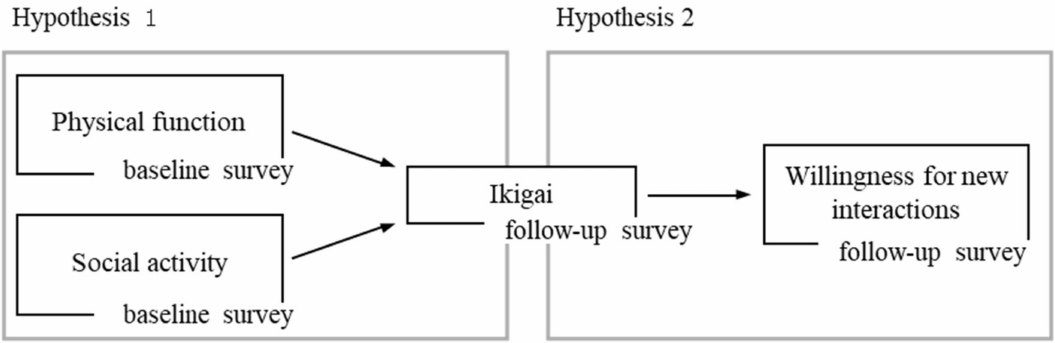
Figure 2. A causal model of predictors (Hypothesis 1) and effects (Hypothesis 2) of